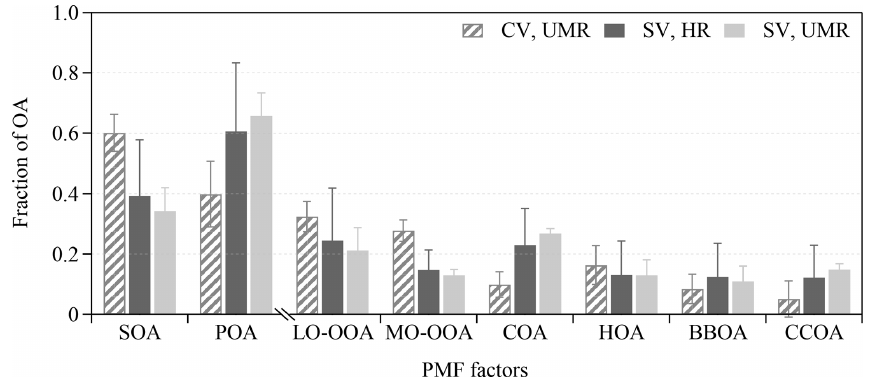
Figure 7. The average fractional contribution to the OA mass by each of the six statistical PMF factors. The uncertainty bars are calculated from the bootstrapping analysis (Table